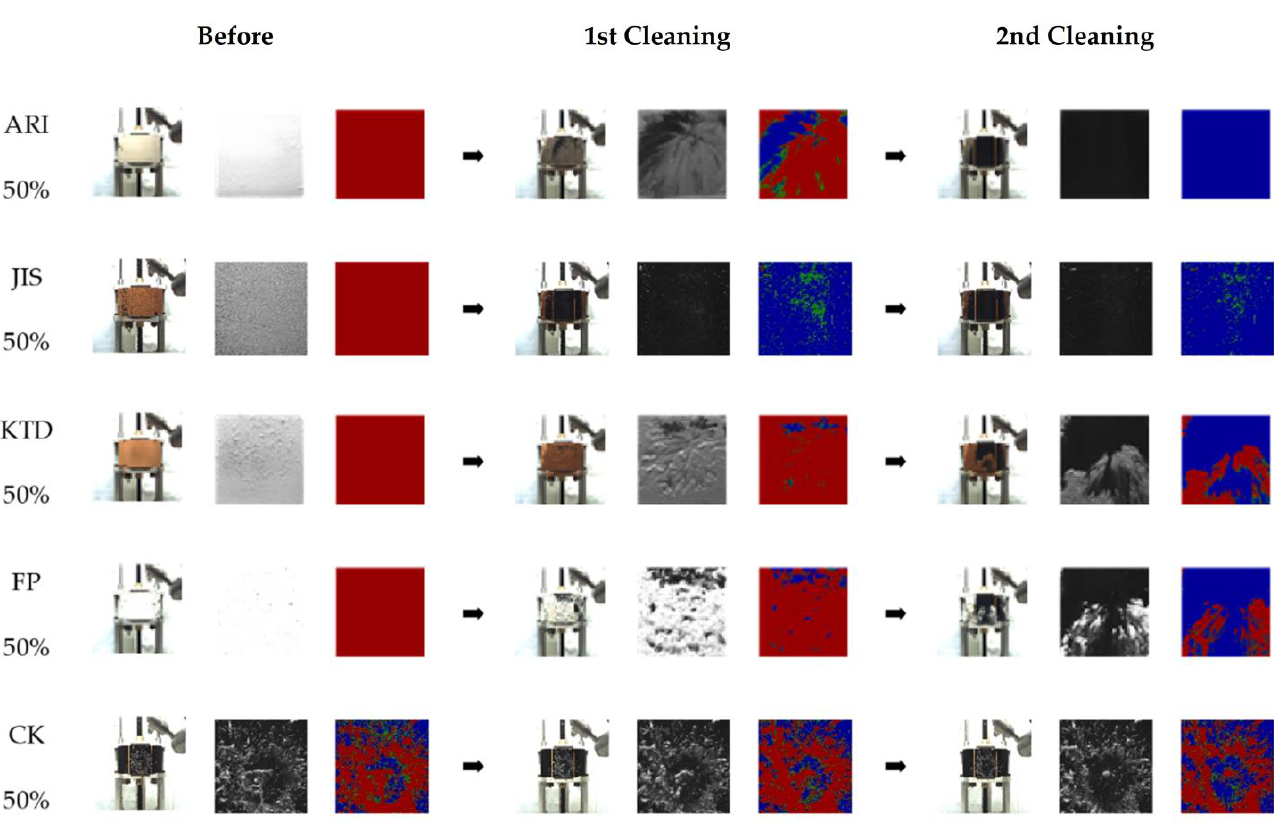
Figure 11. Blockage test flow chart.